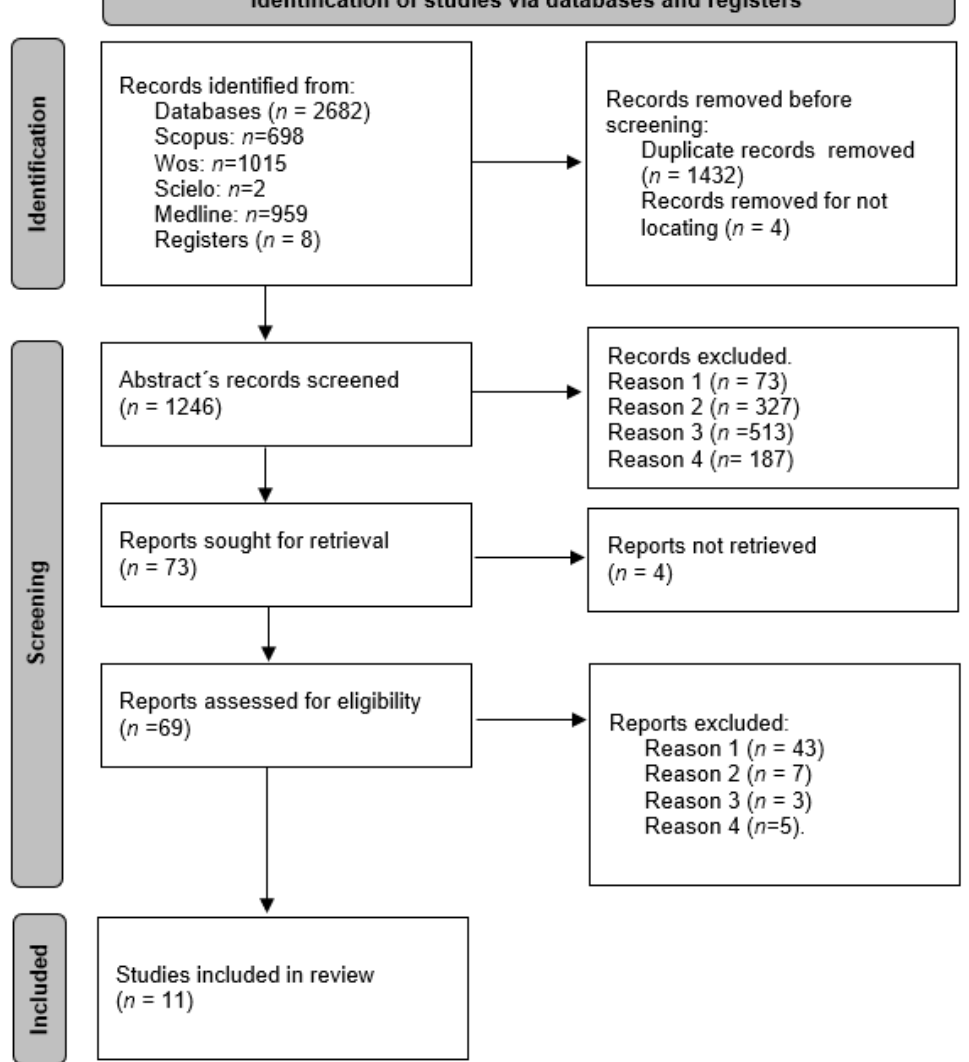
Figure 1. Flow diagram PRISMA 2020 (exclusion criteria: Reason 1—not collecting RTCs in the analysis. Reason 2—no CRF data in the analysis of results. Reason 3—noncancer-specific fatigue analy-